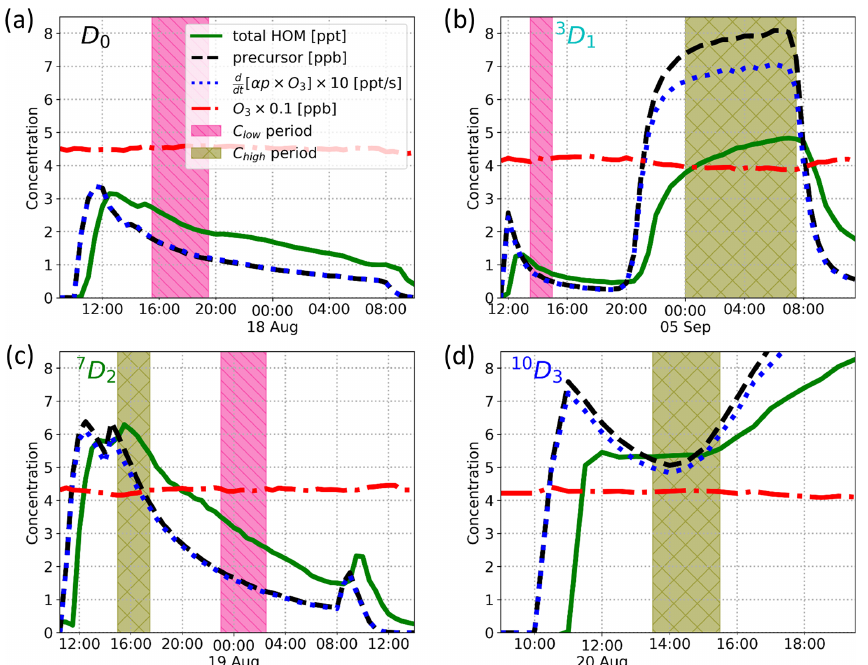
Figure 4. Time series of the experiments showing total HOM concentration (green solid line), precursor concentration (black dashed line), α -pinene ozonolysis rate multiplied by 10 (blue dotted line), and ozone concentration multiplied by 0 . 1 (red dash-dotted line). Additionally, sample times for a low-concentration sample ( C low ) and a high-concentration sample ( C high ) are shown with a magenta “ \ ” hatched area and an olive cross-hatched area,